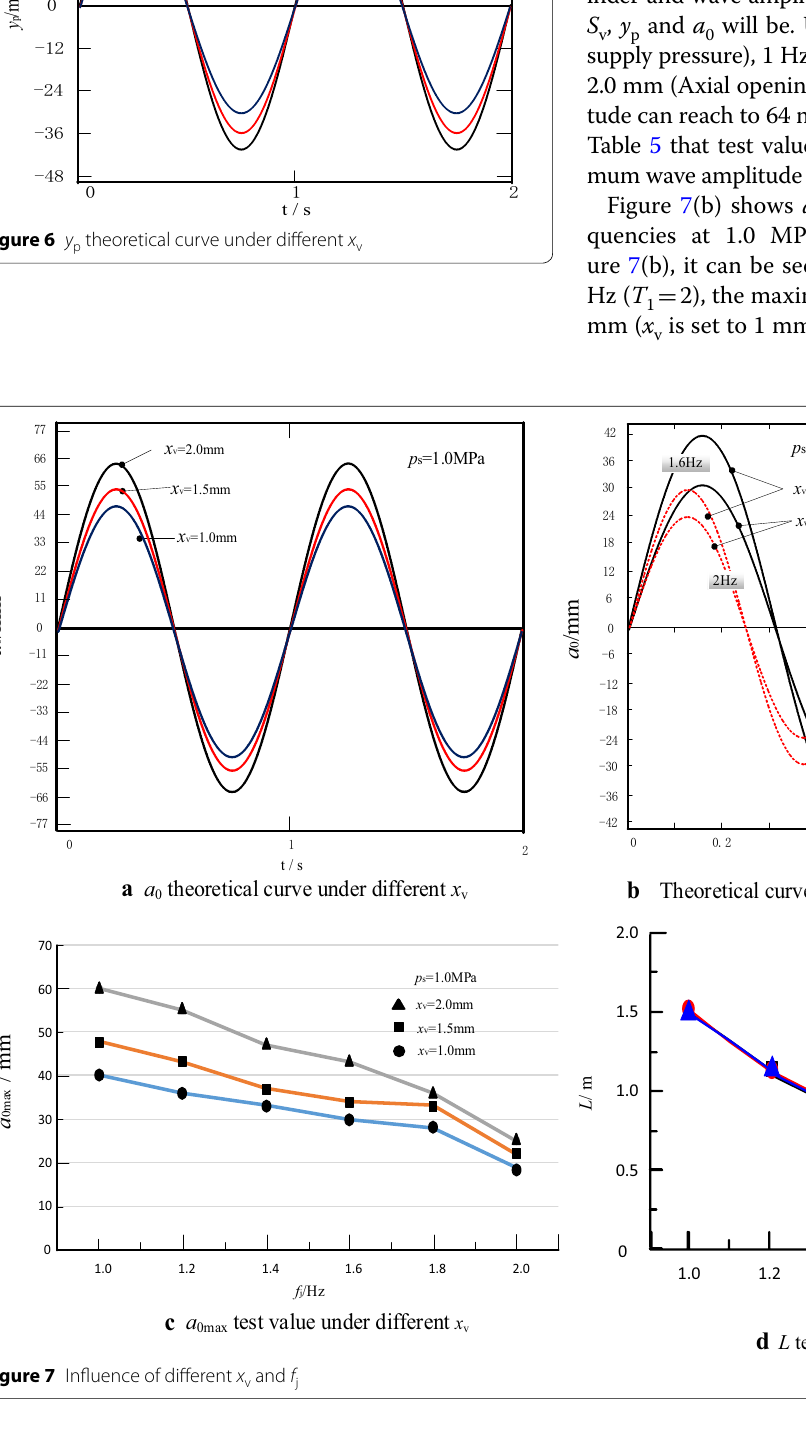
Figure 7 Influence of different x v and f